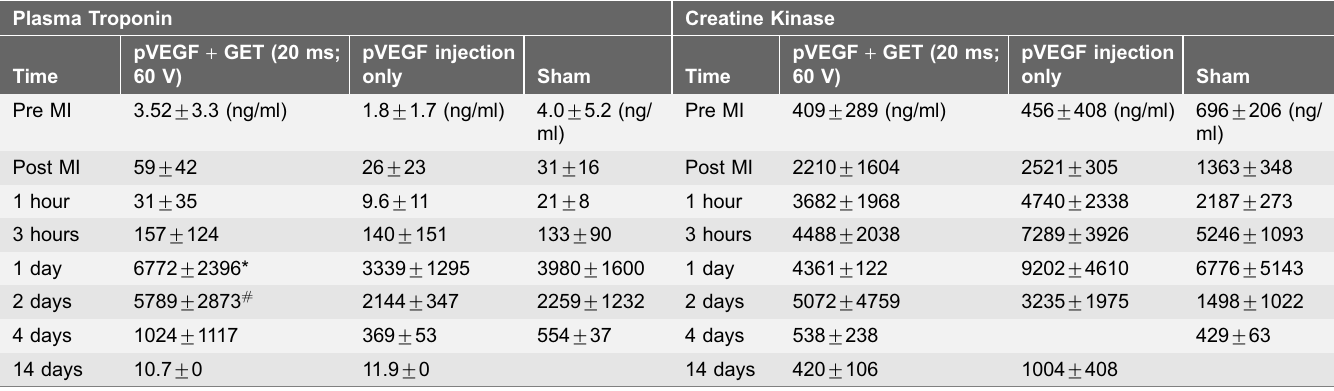
Table 2. Plasma troponin and creatine kinase measurements before and after occlusion of the LAD coronary artery. Plasma Troponin Creatine Kinase